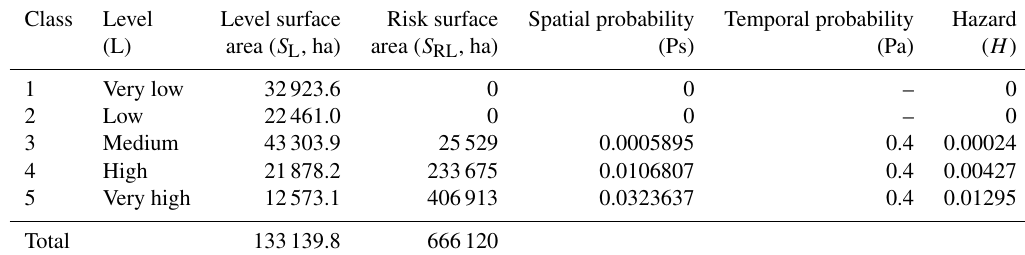
Table 4. Probability of occurrence and associated hazard by susceptibility level.